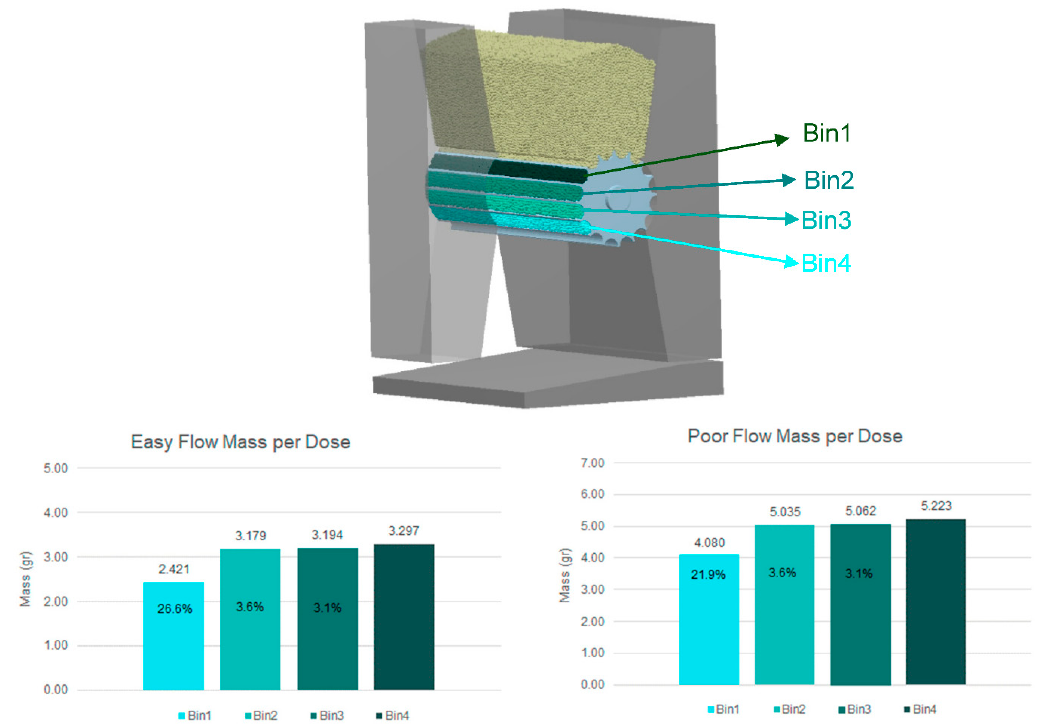
Figure 7. Schematic of the dosing wheel showing the calculated amounts of mass per dose unit for each powder material, as well as their reduction rates.